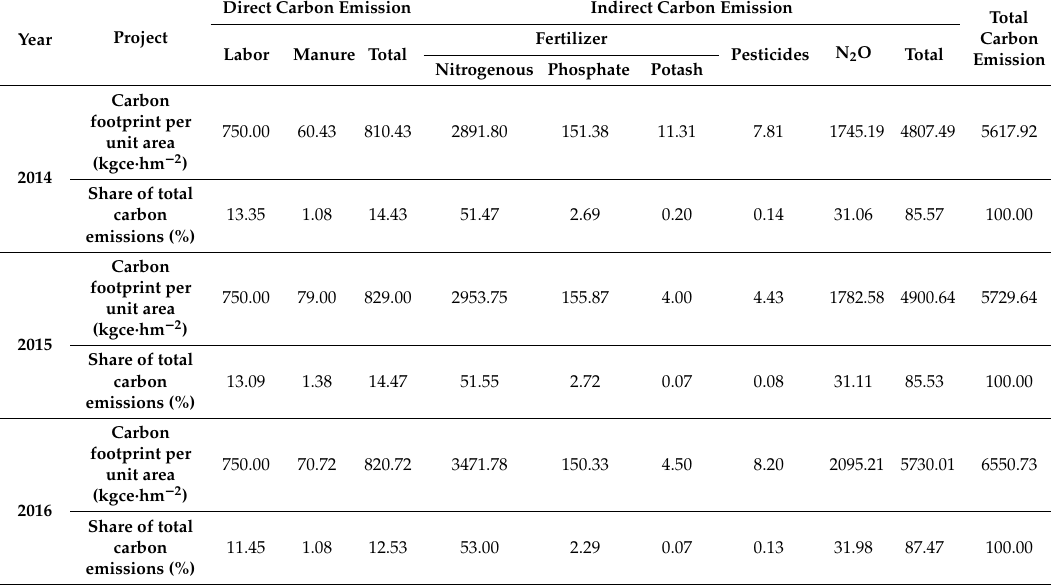
Table 3. Carbon footprint of mulberry planting in di ff erent